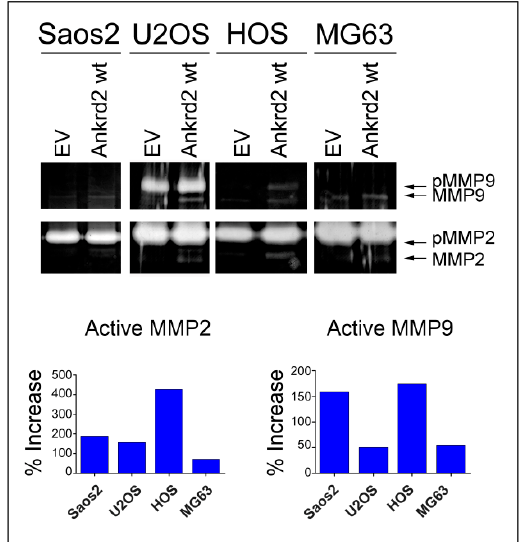
Figure 6. Ankrd2 overexpression affects the activity of MMP2 and MMP9. A total of 1 × 10 6 cells from Saos2, U2OS, HOS and MG63 clones overexpressing Flag-Ankrd2wt, or transfected with empty vector (EV), were seeded into a 35 cm 2 petri dish and serum starved for 24 h. After additional 36 h, media were collected and assayed for their gelatinolytic activity. Total protein (7 μ g) from media was resolved on a gelatin embedded polyacrylamide gel under non denaturing conditions. Gelatinolytic activity of MMP2 and MMP9 was visualized as unstained (white) bands. Protease activity of MMP2 and MMP9 in OS clones expressing Ankrd2 wt is reported as the percentage increase with respect to control (empty vector-transfected) clones. MMP2 and MMP9 appeared as two bands corresponding to the inactive pro-enzyme (indicated as pMMP2 and pMMP9) and to the cleaved active form (MMP2 and MMP9).